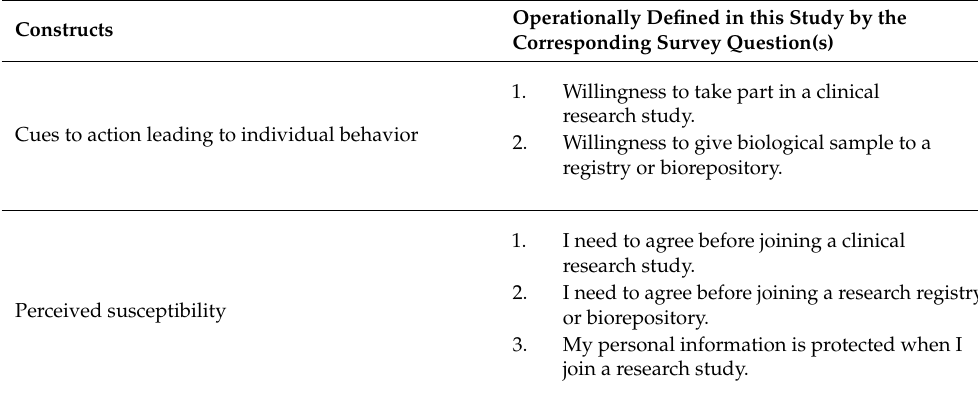
Table 1. Health Belief Model: Constructs examined and defined in this